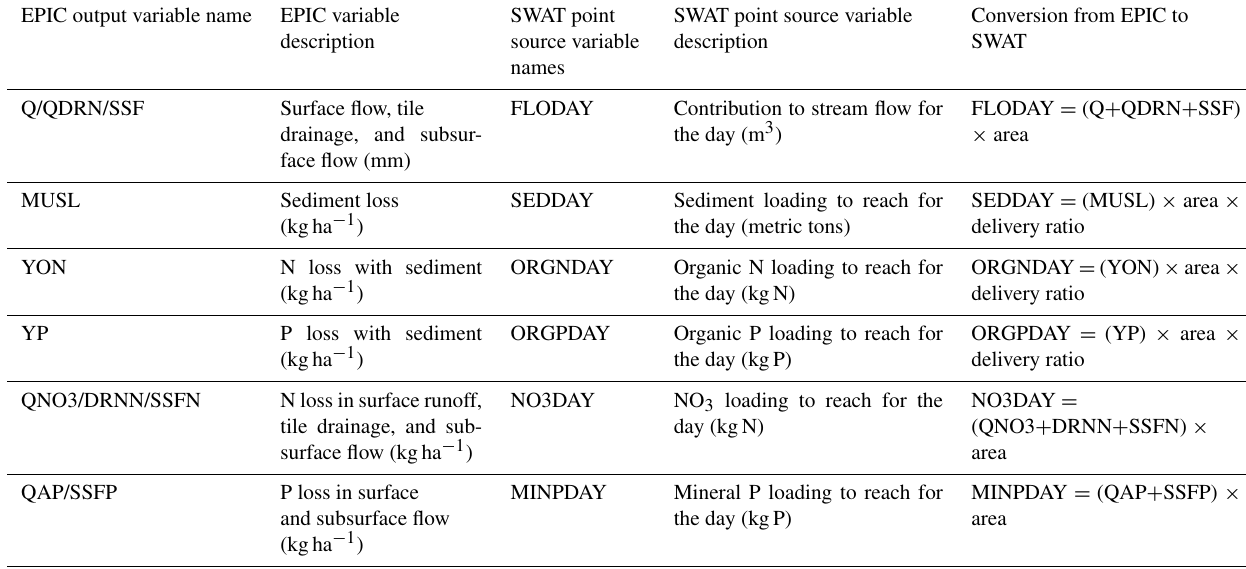
Table 1. EPIC daily output variables converted to SWAT point source